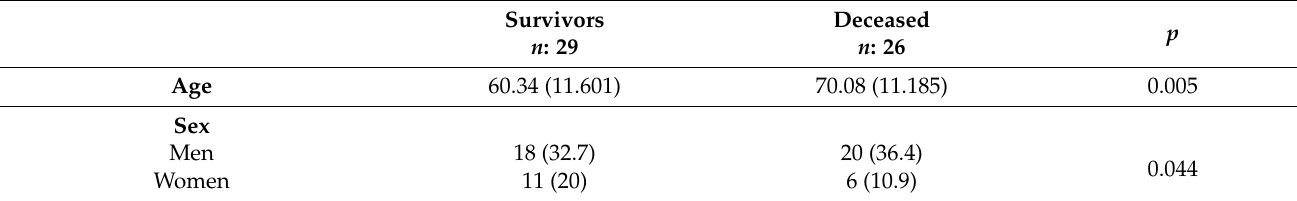
Table 1. Comparison of the sociodemographic and clinical characteristics between survivors and deceased patients after five years of